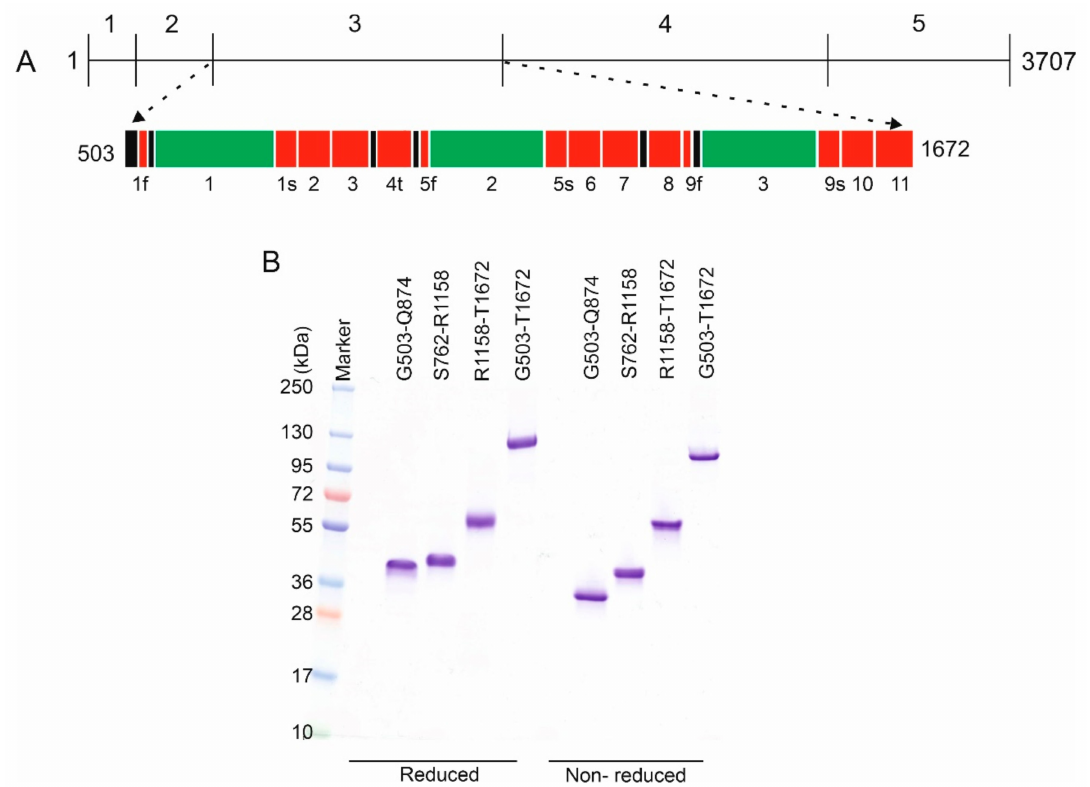
Figure 3. Production of region 3 of perlecan. ( A ) Schematic of the domain organization of perlecan. Amino acid numbering for the proteins and the domain constructs are shown. Di ff erent domains are colored separately: laminin IV type A-like domain (green), laminin Epidermal Growth Factor (EGF)-like domain (red) and unassigned sequence regions (black). Numbering (1–5) shows di ff erent regions of perlecan [30]. Region 3 contains 3 laminin IV type A-like domains and 11 laminin EGF-like domains. The laminin IV type A-like domains split the laminin EGF-like domains 1, 5 and 9 into two parts (where “f” stands for first part, “s” for second part, “t” stands for truncated). ( B ) Representative coomassie stained SDS-PAGE gels of reduced and non-reduced samples of purified region 3 constructs of perlecan. Only single bands are visible in the non-reduced samples suggesting that the proteins are in a single redox